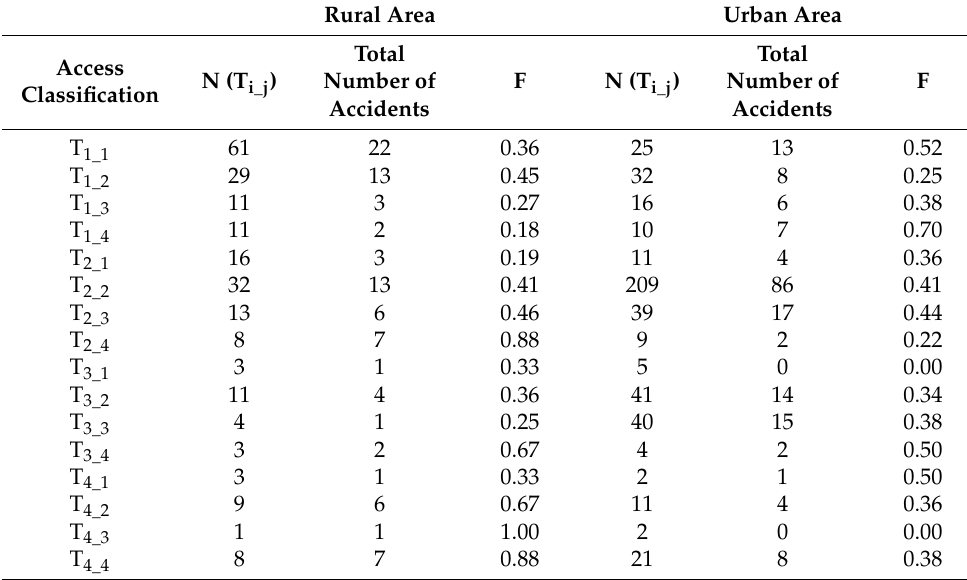
Table 8. Analysis of the rural and urban areas. Rural Area Urban